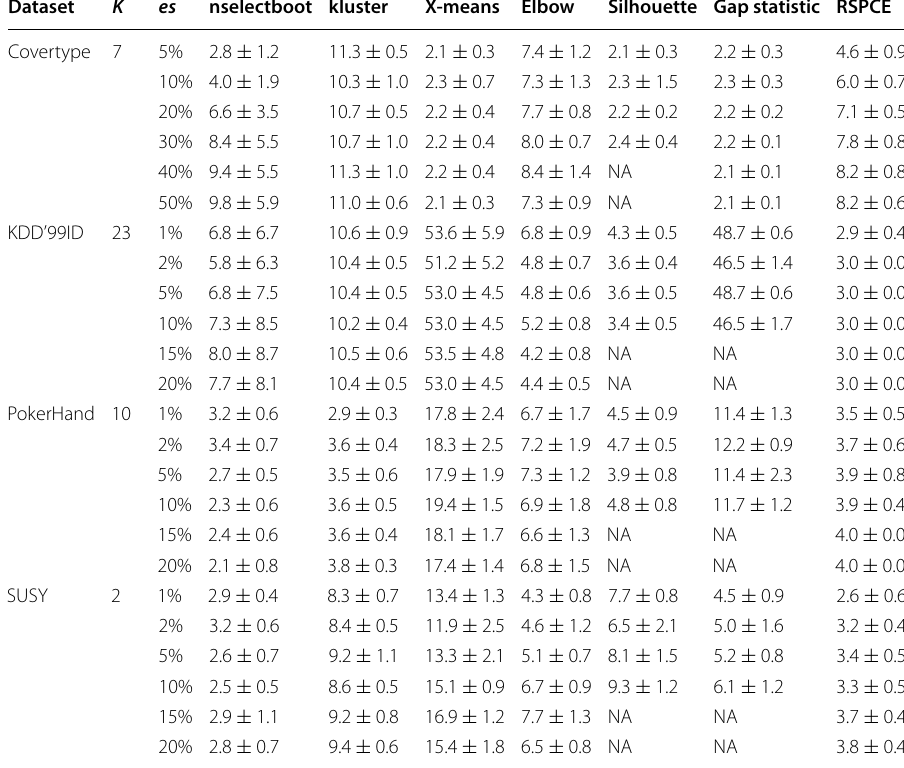
Table 7 Comparison of the estimated number of clusters produced by different methods on the real-world